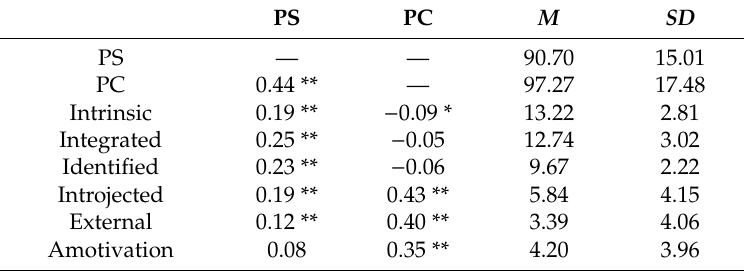
Table 1. DescriptivestatisticsandbivariatecorrelationsbetweenPerfectionisticStrivings(PS),Perfectionistic Concerns (PC) and the Behavioral Regulation in Exercise Questionnaire (BREQ-3) subscales.